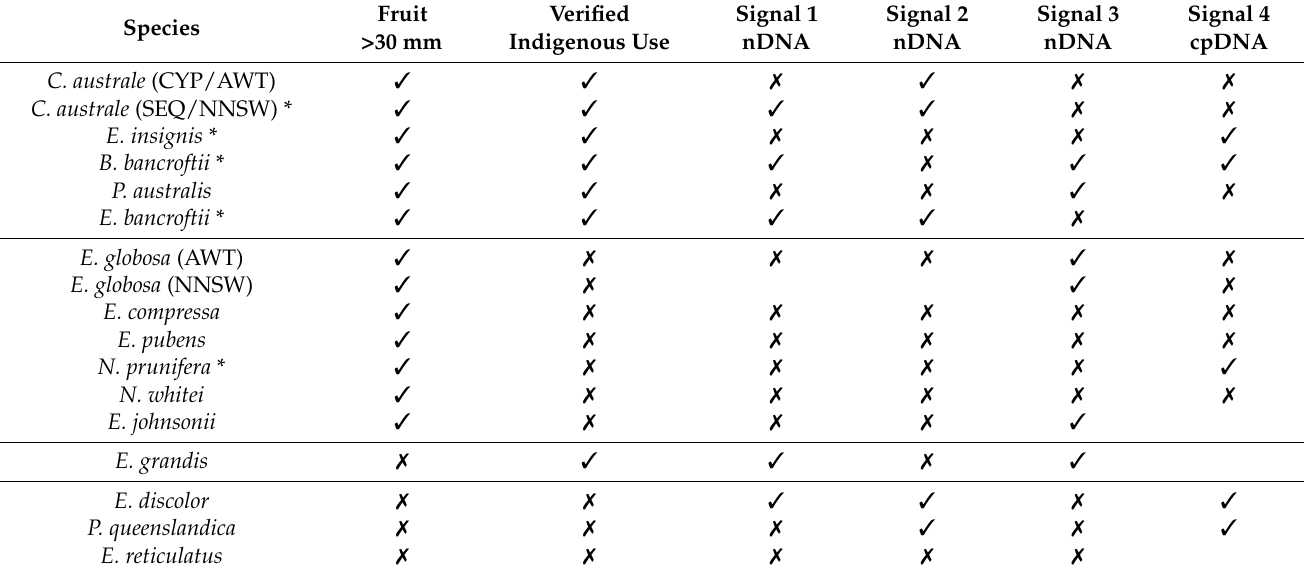
Table 3. Summary of dispersal signals found in the study species. The presence or absence of these signals can be used to evaluate whether a species would make a suitable candidate to investigate the influence of Indigenous dispersal. Signal 1 = “low Fst values and absence of IBD”. Signal 2 = “admixture between sites”. Signal 3 = “genomic outliers within sites”. Signal 4 = “haplotype LDD”. Species identified as candidates for Indigenous dispersal studies have an asterisk *.